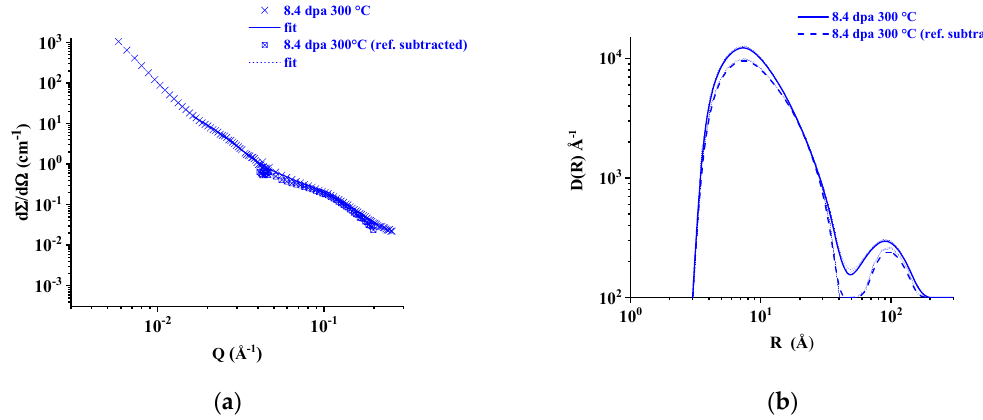
Figure 7. Eurofer97 neutron irradiated to 8.4 dpa at 300 °C: ( a ) best fits to nuclear SANS cross-section without (crosses) and with (empty squares) subtraction of reference sample’s cross-section, ( b ) best-fit micro-void distributions (Å − 1 ) obtained without (continuous line) and with (dashed line) subtraction of reference sample’s cross-section. The 80% confidence bands are indicated by the dotted lines.